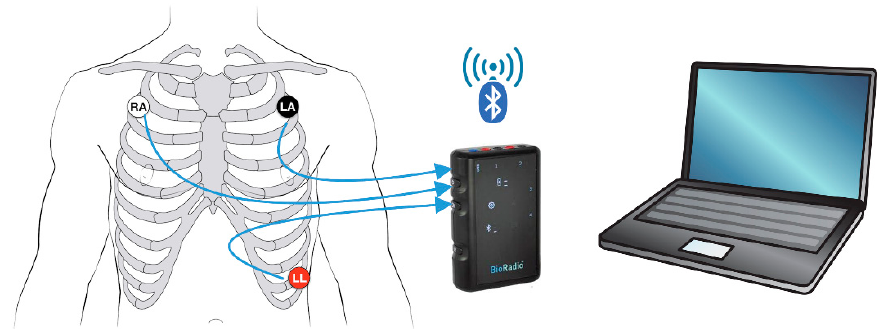
Figure 1. The conventional electrocardiogram (ECG) system.